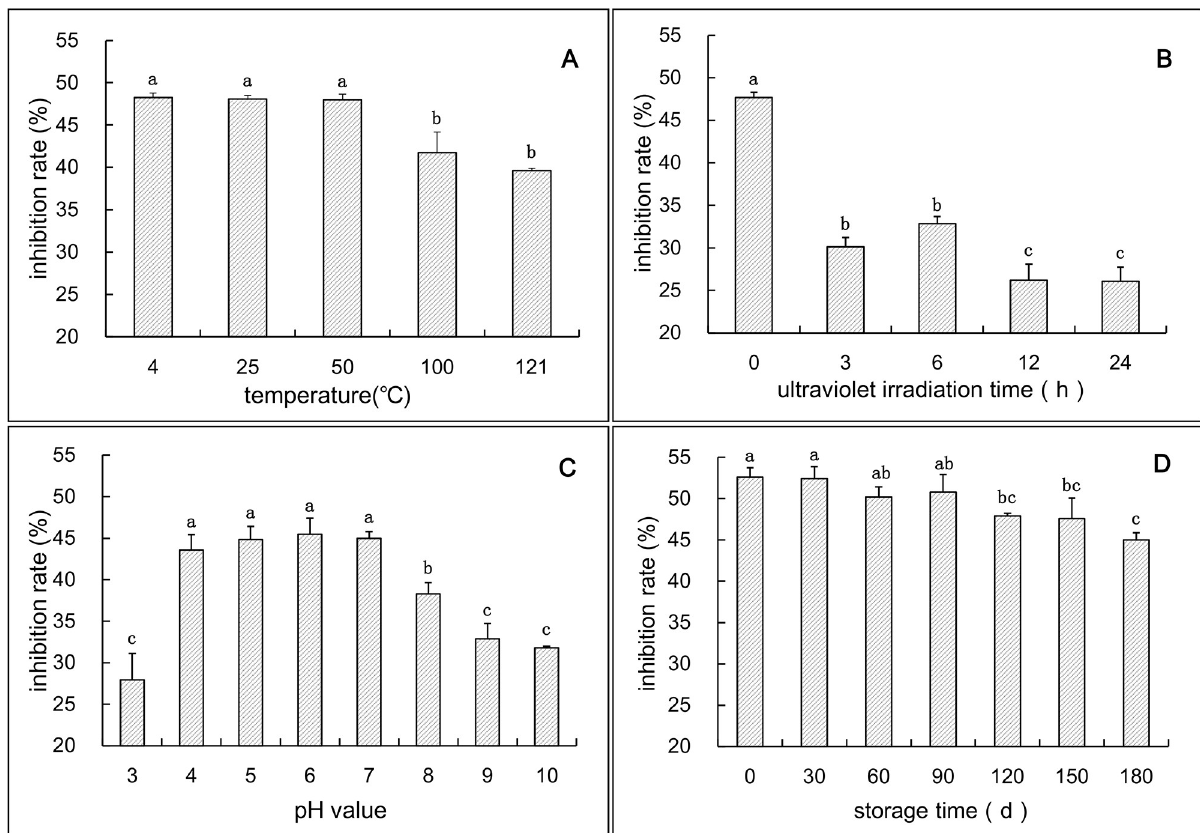
Fig 3. Antifungal activity of canthin-6-one alkaloid treated by different factors. A, temperature treatment; B, ultraviolet irradiation treatment; C, acid or alkali treatment; D, storage time. Different letters indicate significant differences ( p < 0.05).